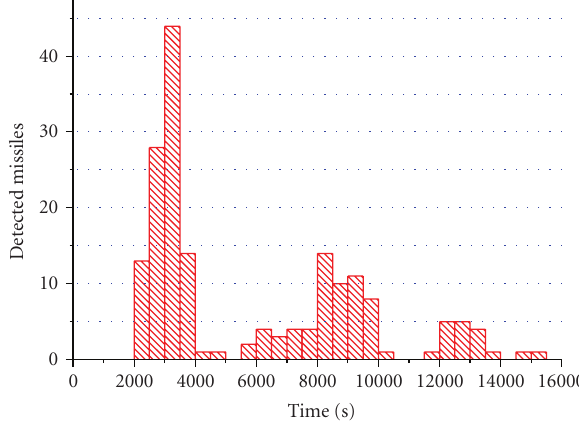
Figure 3: Launched opponent missiles during a match, showing wave-pattern of attacks. The time shown is in-game